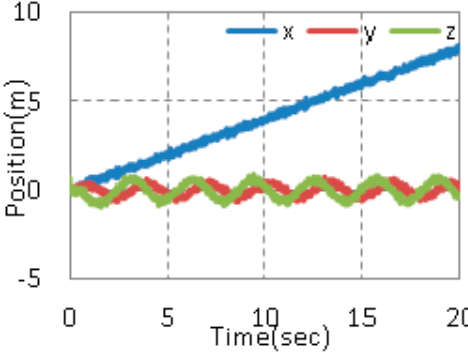
Figure 12. Actual position of quadrotor in the experiment.